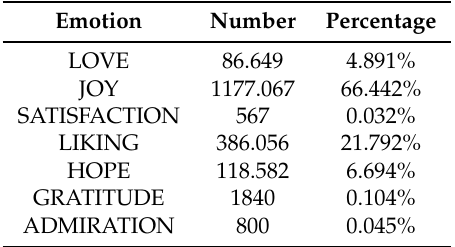
Table 6. Emotions classified to be demonstrated by the robot.